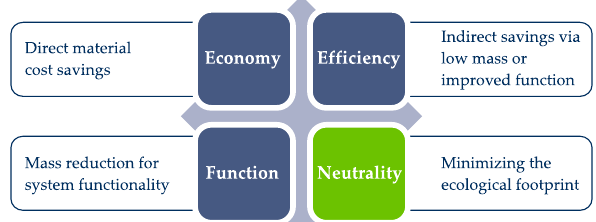
Fig. 2 The three classical lightweight engineer- ing classes (blue) with the proposed additional class of Neutral Lightweight Engineer- ing (green) and their major development